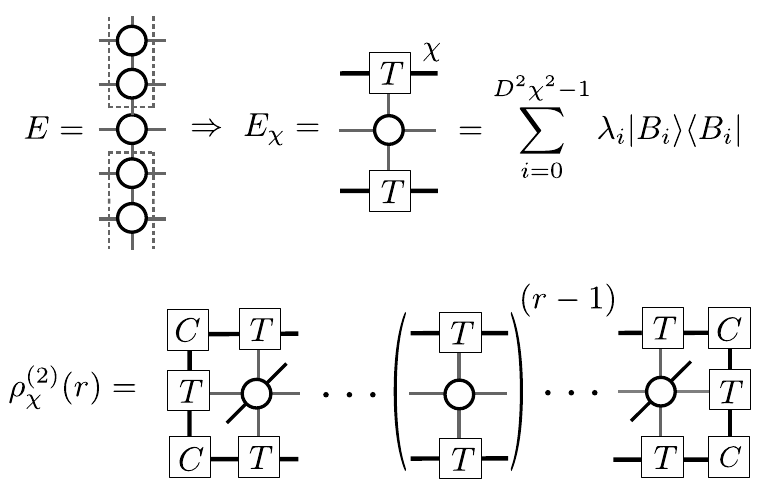
Figure 3: Top: Definition of the transfer matrix E and its finite- χ approximation E χ given by the converged T tensor. Due to C symmetry imposed on the ansatz, the 4 v transfer matrix is symmetric and can be diagonalized. Eigenvalues are ordered with descending magnitude with the leading eigenvalue λ normalized to unity. Bottom: 0 RDM for two-point correlation functions, defined for r ≥ 1, and its connection to transfer matrix E